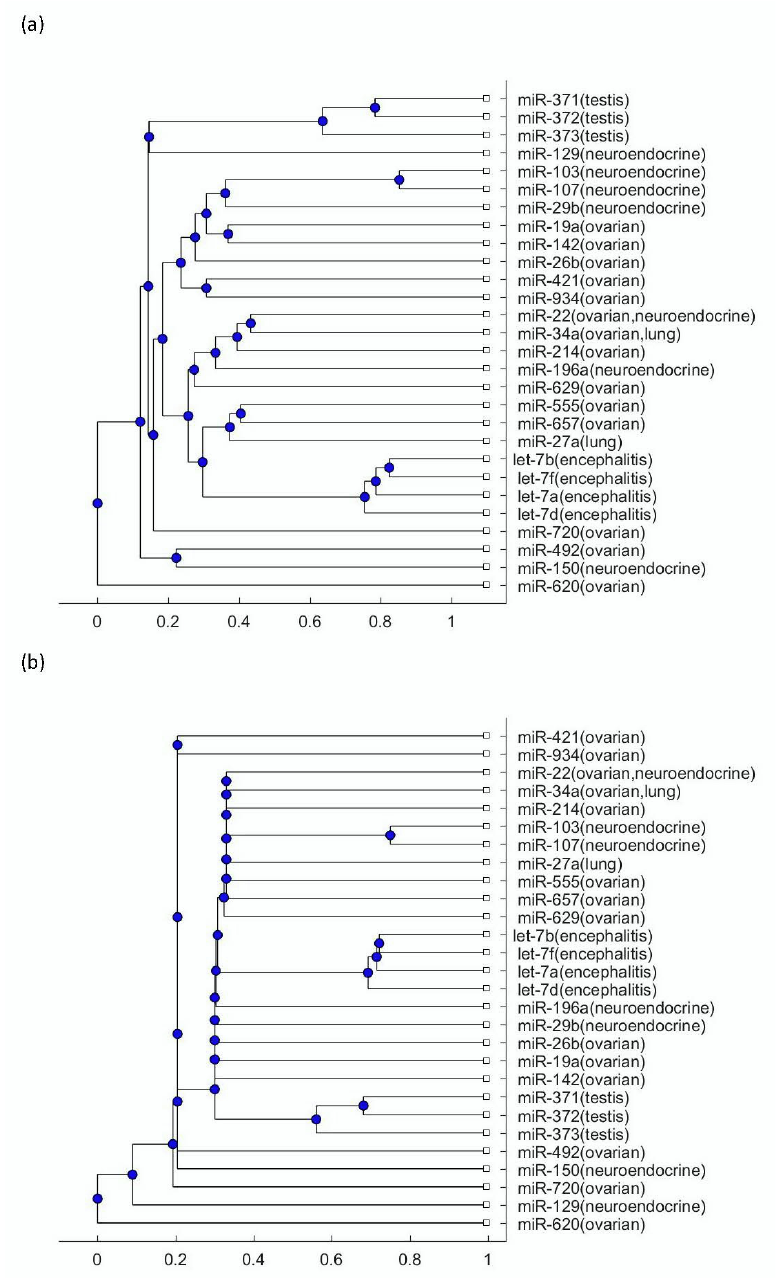
Figure 2. ( a ) The phylogenetic tree of miRNAs shown in Table 1 based on the Jukes–Cantor model distance and the average method. ( b ) The phylogenetic tree of miRNAs shown in Table 1 based on the Jukes–Cantor model distance and the median